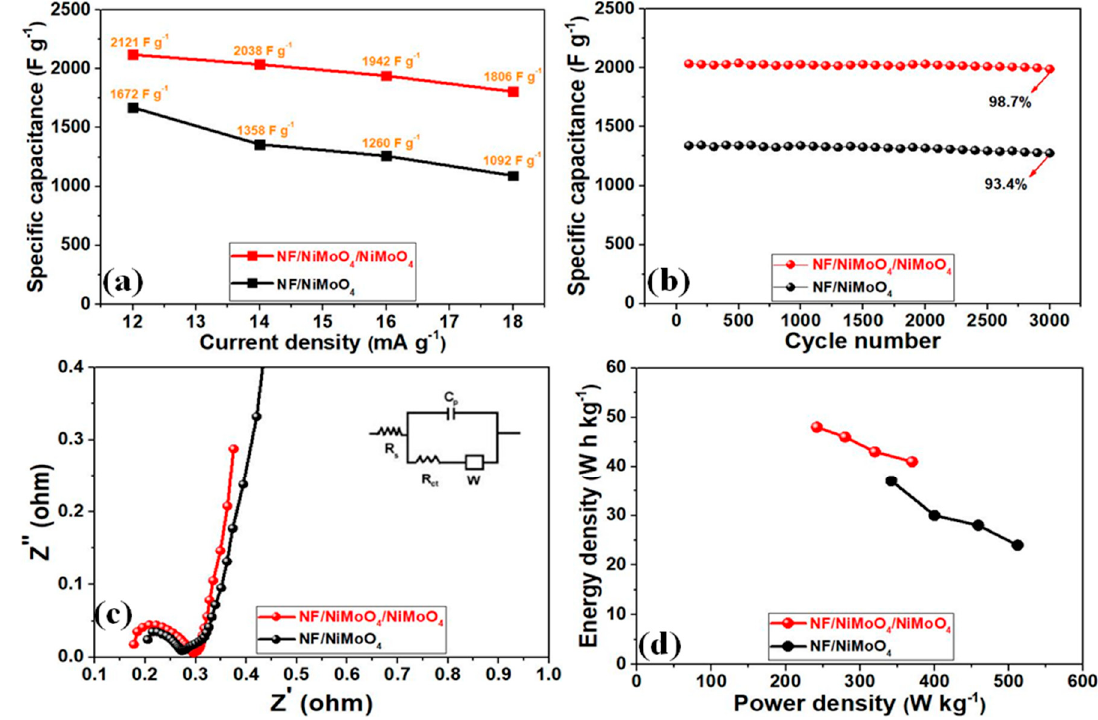
Figure 6. ( a ) Calculated specific capacitance at different current densities, ( b ) Long-term cycling stability, ( c ) Nyquist plots and ( d ) Ragone plot of the NF/NiMoO 4 and NF/NiMoO 4 /NiMoO 4 electrode materials.